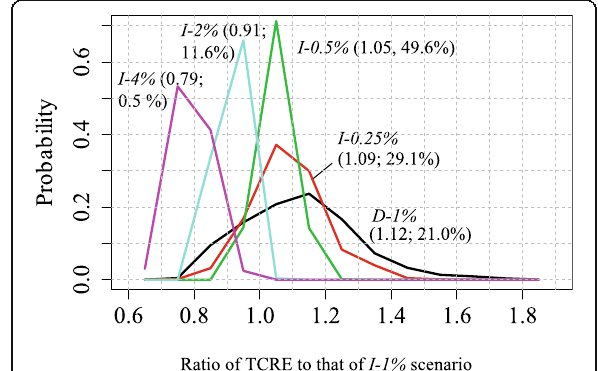
Fig. 2 Weighted probability distributions of the relative change in the TCRE from that of the I - 1 % scenario. The numbers in parentheses indicate the average among all members and the percentages of the members within a ± 5% difference from the value under the I - 1 % scenario: I - 0.5 % (green line); I - 0.25 % (red line); I - 2 % (light blue line); I - 4 % (purple line); D - 1 % (black line; starting